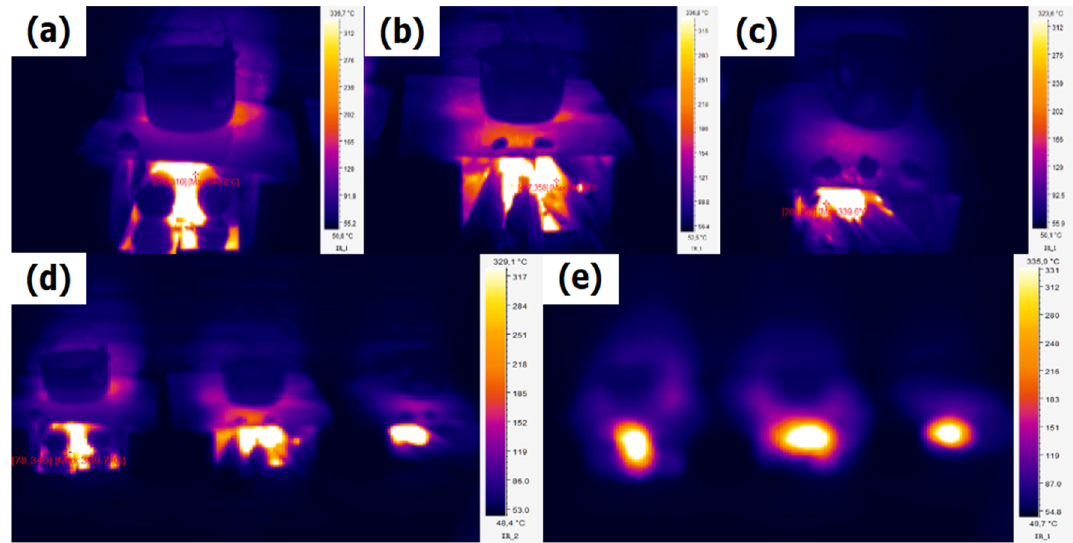
Figure 11. Combustion at 45 min: ( a ) briquette; ( b ) pine firewood; ( c ) oak firewood. ( d ) Integrated image of the three fuels; ( e ) emissions in the form of radiant bodies from the three fuels.